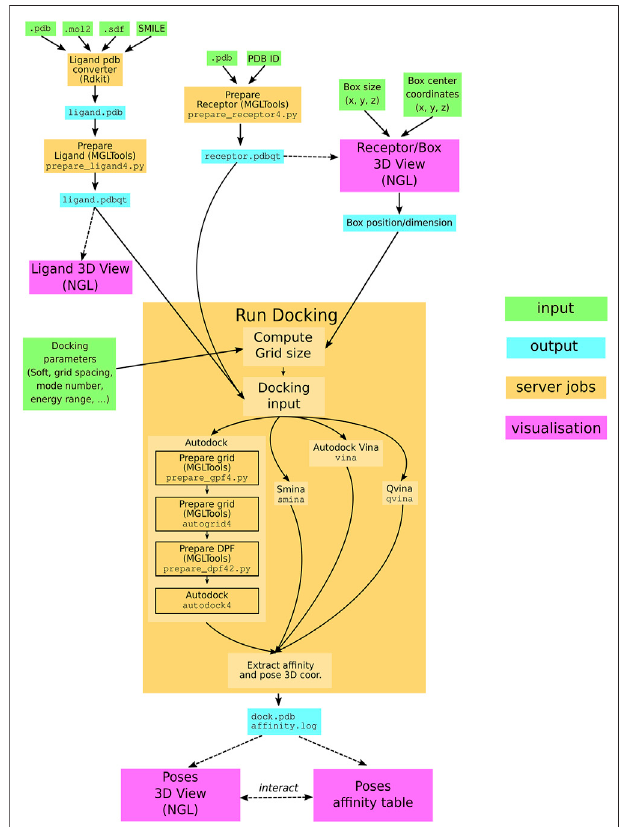
FIGURE1| SeamDockWork fl ow.Schematic fl owdiagram,showingthe general pipeline of SeamDock. The user enters input, shown as green boxes, using the SeamDock web page. The user inputs are synchronized with the web server using JavaScript and Seamless. On the server, inputs, jobs, and outputs are de fi ned in a Seamless work fl ow. Seamless will execute jobs upon input changes. Jobs are implemented as Python scripts using docking_py,invokingthevariousdockingtools.Resultsaresynchronizedwith the webpage using Seamless. Output structuresarethen shown using tables and the NGL